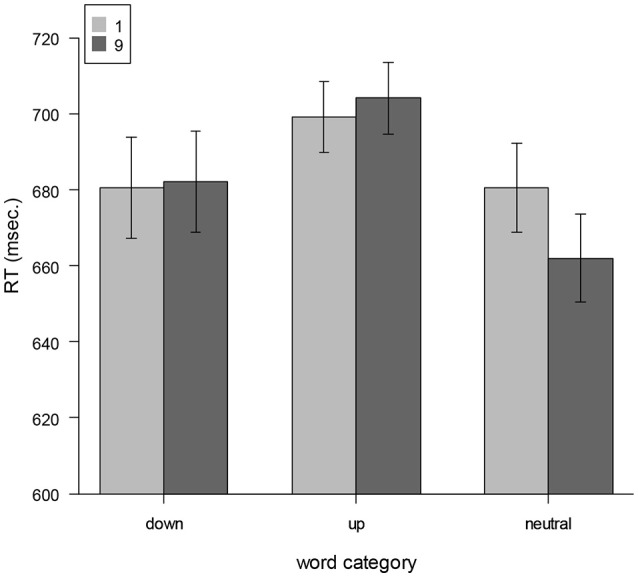
Mean reaction times as a function of implicit locational association of words (up, down, neutral) and numbers (high, low). Error bars represent 95% confidence intervals.